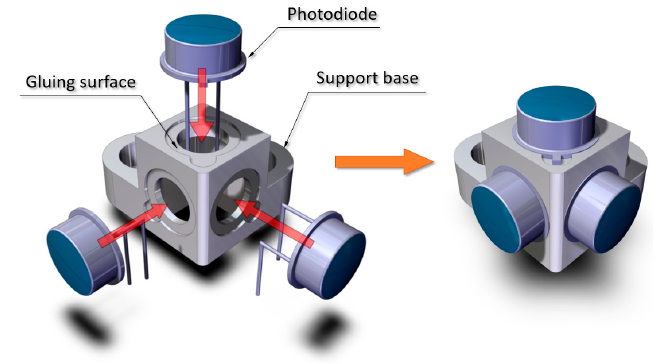
Figure 3. Assembly of the photodiodes on the support base.